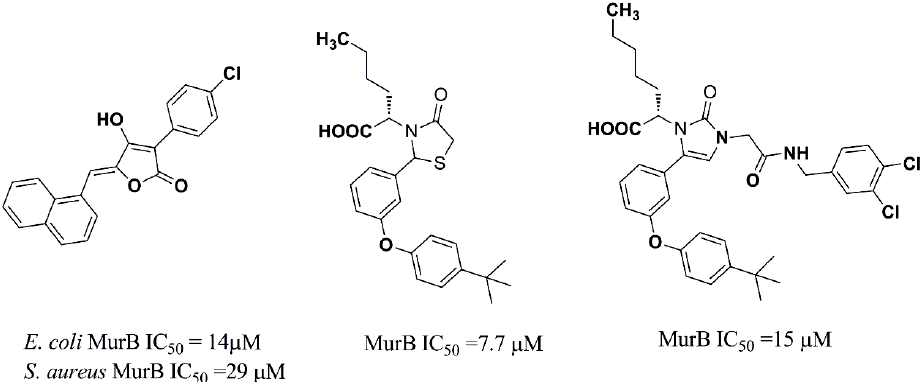
Figure 1. Examples of small molecule MurB inhibitors with their reported antibacterial activity.